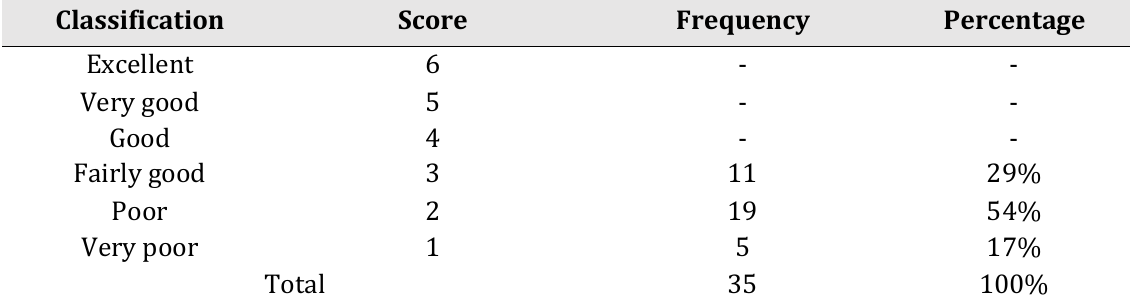
Table 8. Rate Percentage Point of Learners’ Fluency in Pre -test result